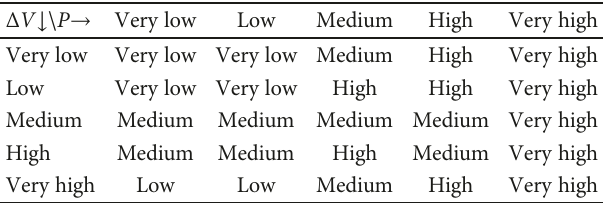
Table 2: Rules of the fuzzy